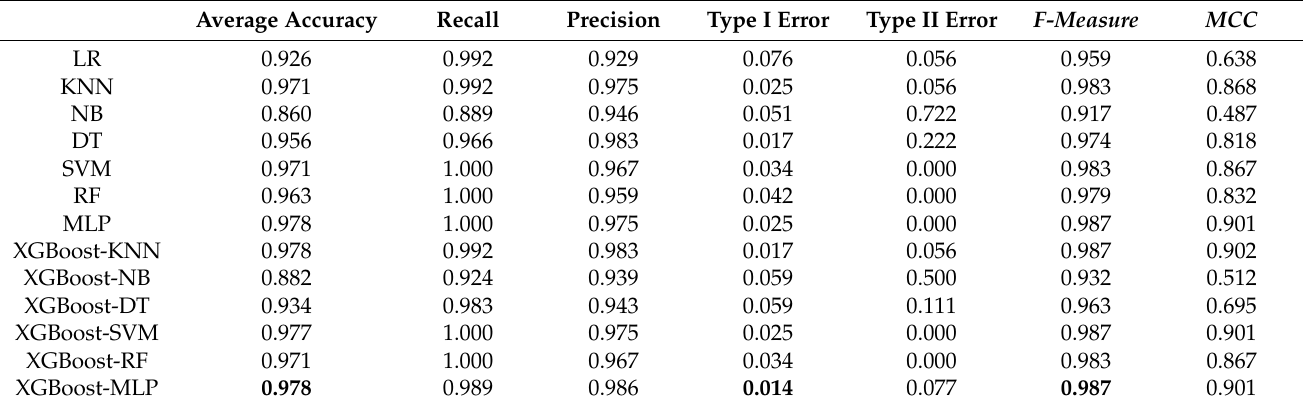
Table 7. Performance of XGBoost-MLP and other machine learning methods. (Test set = 0.1).